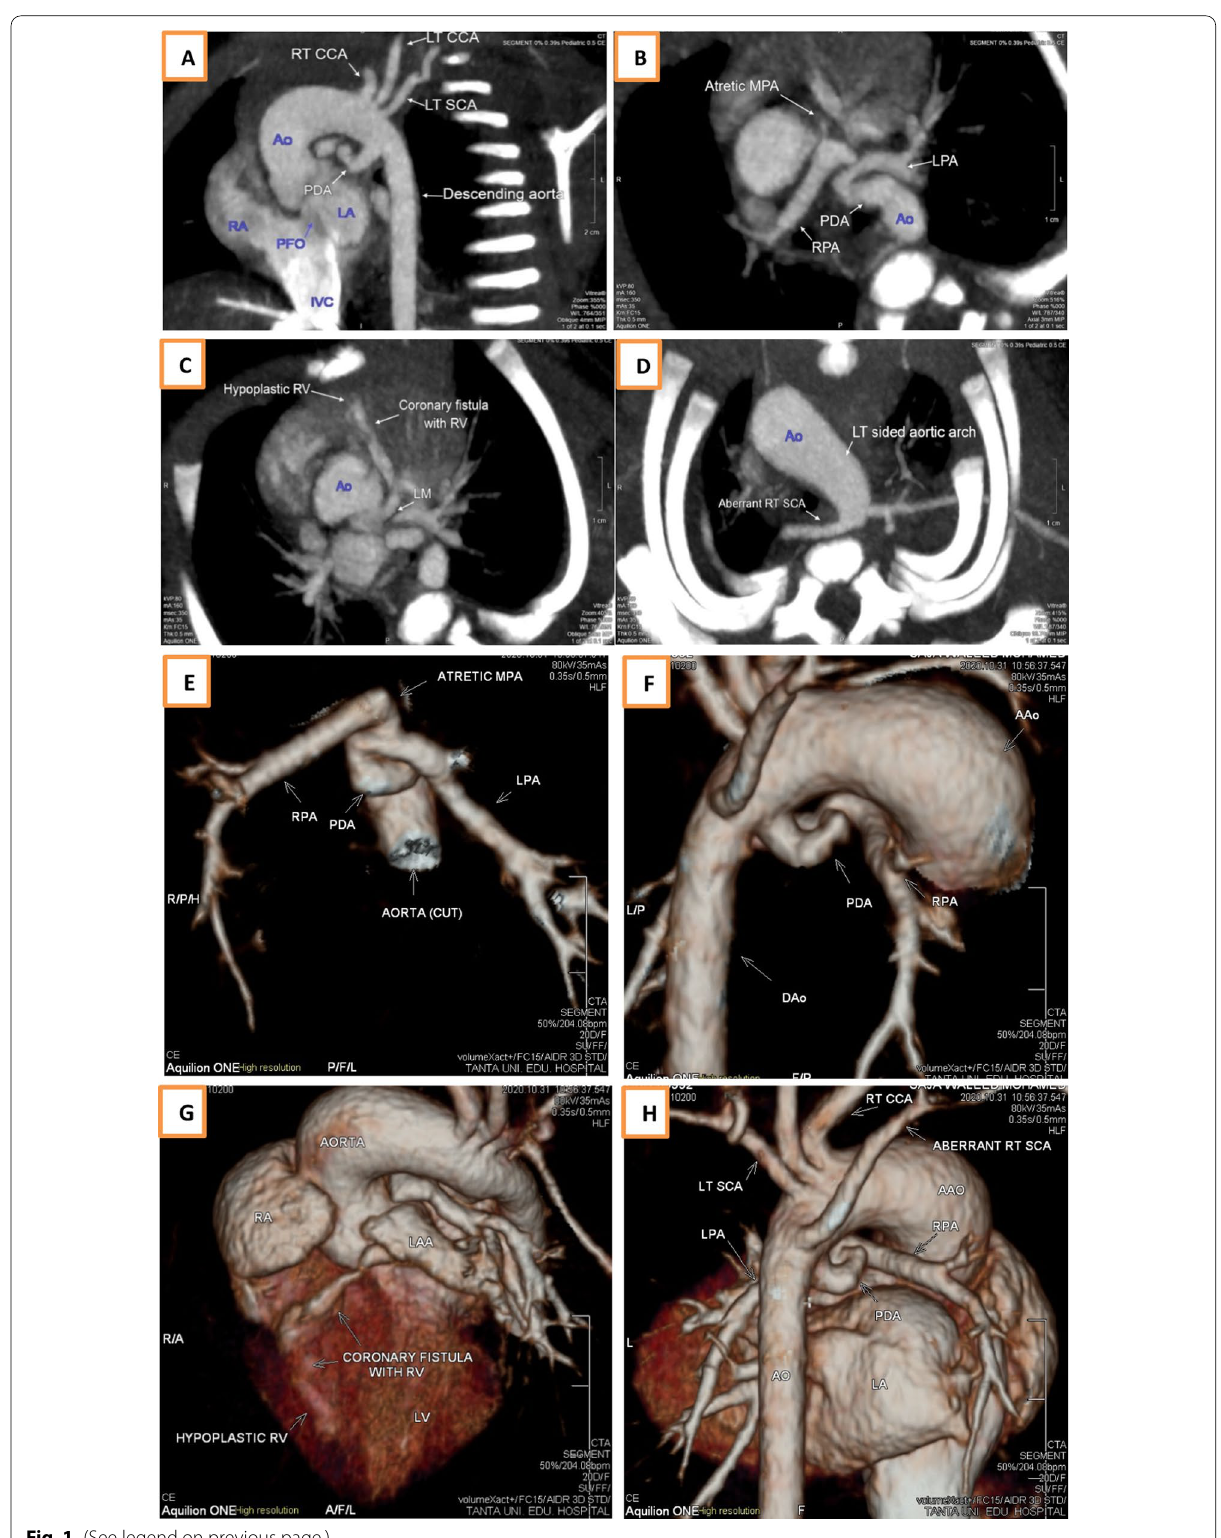
Fig. 1 (See legend on previous